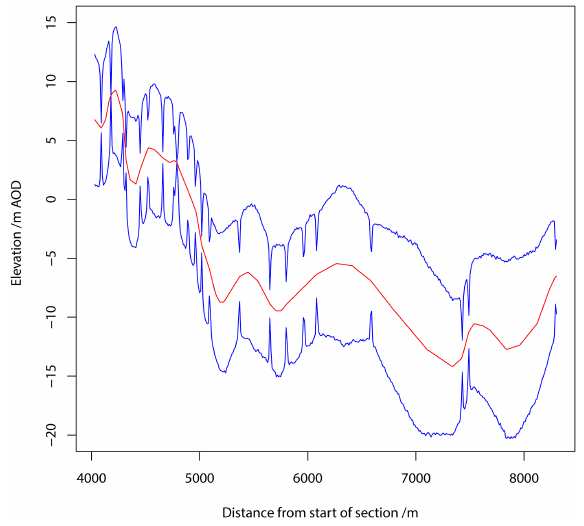
Figure 5. One geologist’s interpretation of the base of the London Clay (red) with 95% confidence intervals (blue).